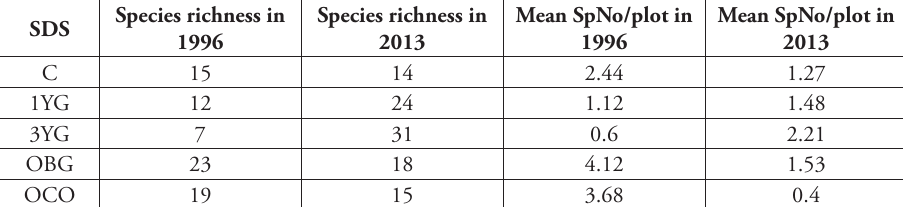
Table 5. Species richness in 1996 and 2013 in the five stand developmental situations (SDS). For expla- nations of the stand developmental situations, see methods. SpNo = species